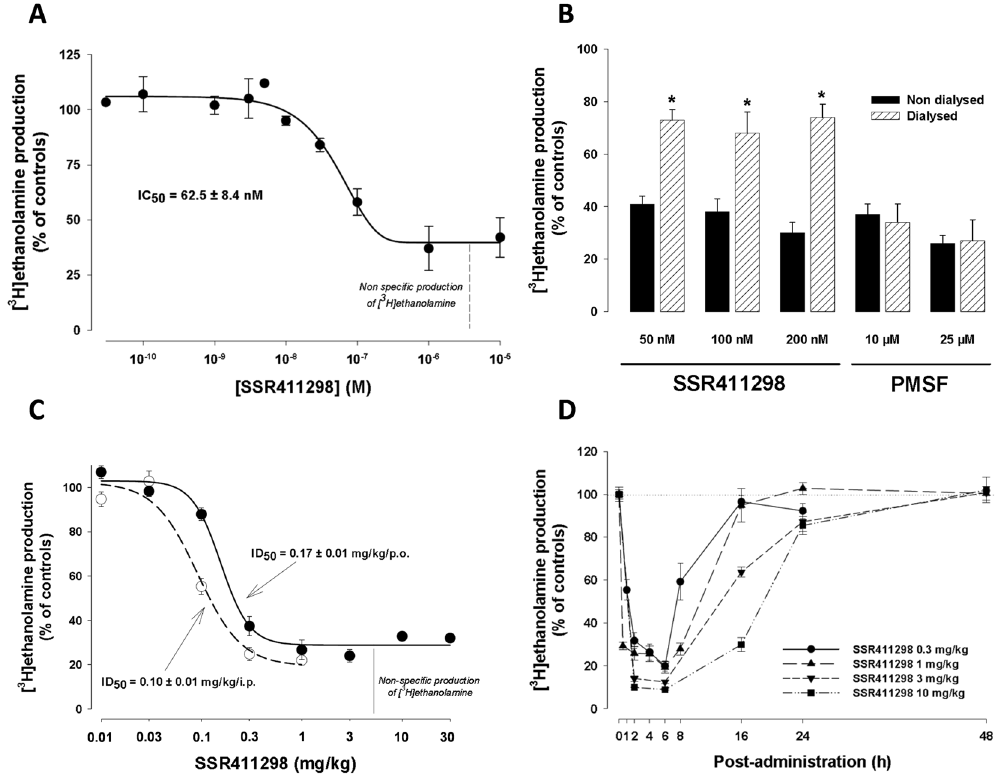
Figure 2. ( A ) Inhibitory effect of SSR411298 on mouse brain FAAH. Brain homogenates were incubated with 10 μ M of [ 3 H]anandamide in the absence (controls) or presence of increasing concentrations of SSR411298 (3 × 10 − 11 M to 10 − 5 M). Data are the mean ± SEM of 4 independent experiments; ( B ) Reversibility of the effects of SSR411298 and PMSF on mouse brain FAAH activity by dialysis. For each concentration, data are the mean ± SEM of mouse brain FAAH activity estimated by measuring [ 3 H]ethanolamine production, expressed in percent of mean of controls after 16 to 18 hours at 25 °C without (black bars) or with dialysis (hatched bars). * P < 0.05 versus non dialyzed (Student’s t-test); ( C ) Ex vivo effect of SSR411298 on mouse brain FAAH